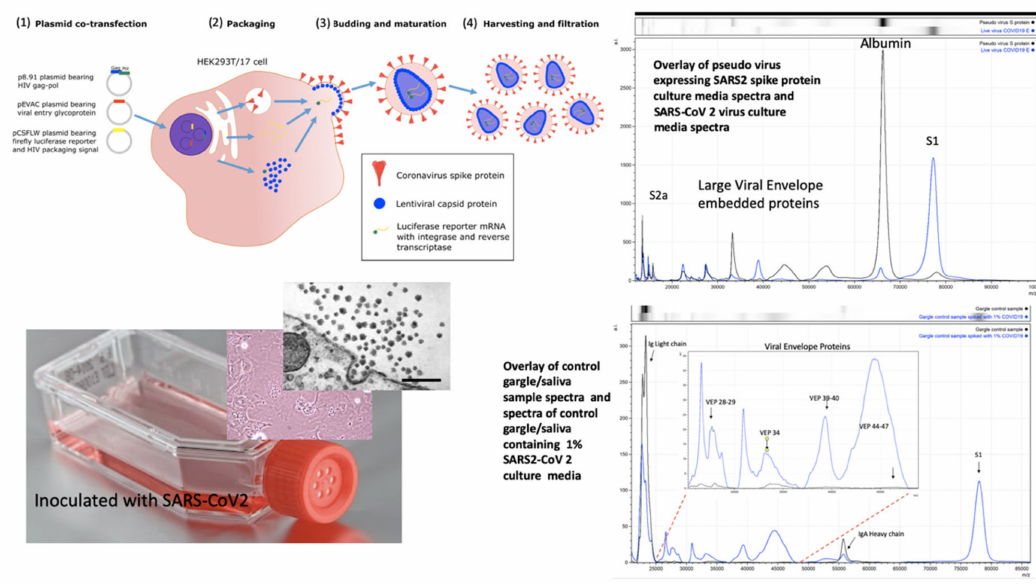
Figure 3. Mass spectral profiles of Pseudo Virus expressing SARS-CoV-2 Spike S protein grown in culture, SARS-CoV-2 virus grown in vitro and mass spectra of gargle / saliva spiked with culture media from cells infected with SARS-CoV-2: S proteolytic fragments S1 and S2 were seen in all preparations and S2b only in serum free samples. Viral envelope proteins (VEPs) became more prevalent in live virus culture and Ig light chains and IgA heavy chain were additional peaks found in gargle / saliva samples. HEK293T / 17 cells were seeded into 6 well cell-culture plates and co-transfected after 24 h with p8.91 (gag-pol expression plasmid), pCSFLW (luciferase reporter plasmid), and a viral